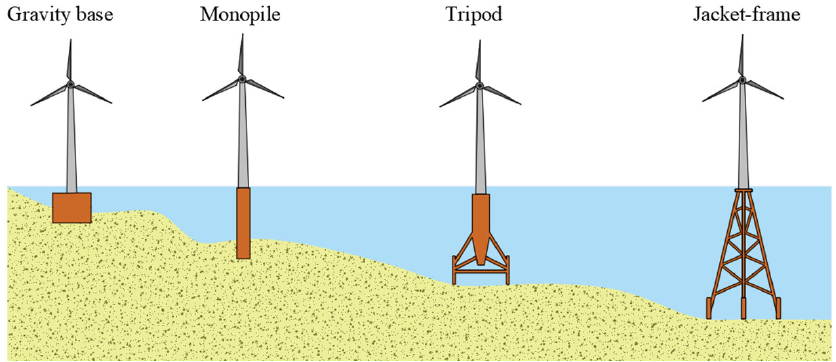
Figure 4. Schematic diagram of fixed offshore wind turbine.